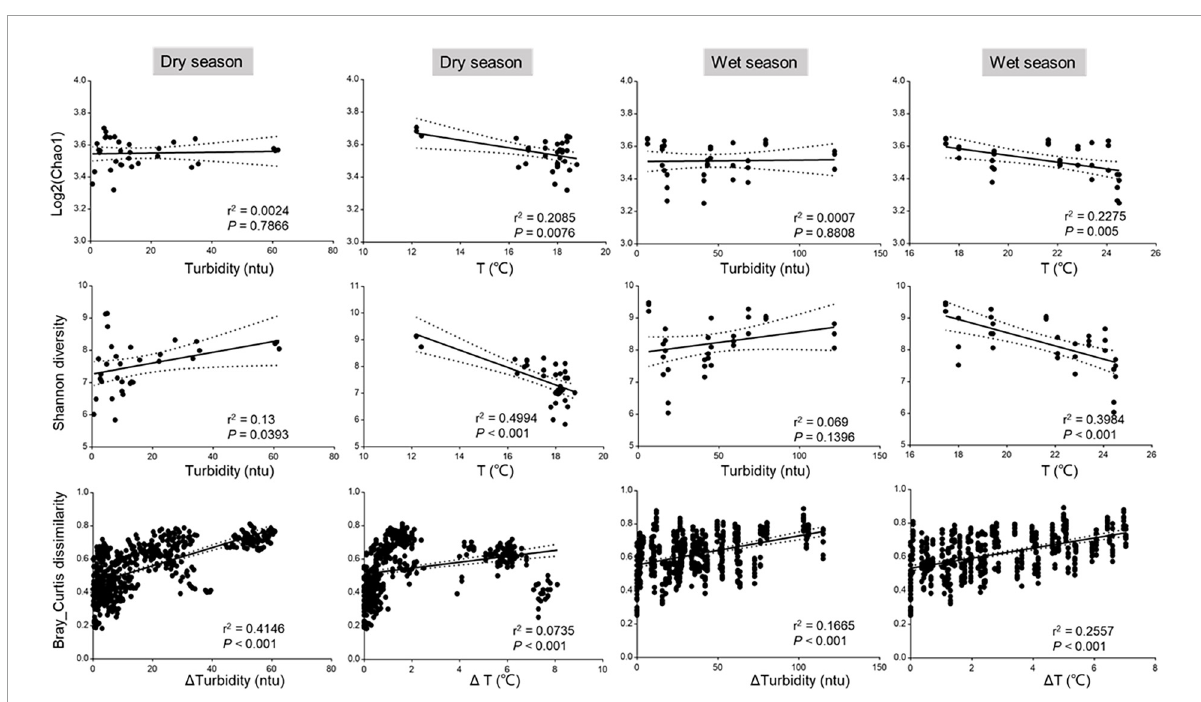
FIGURE5 Linear regression analysis of correlations between the Chao1 diversity, Shannon diversity, and Bray–Curtis dissimilarity of bacterial communities and key environmental factors. Chao1 diversity values were